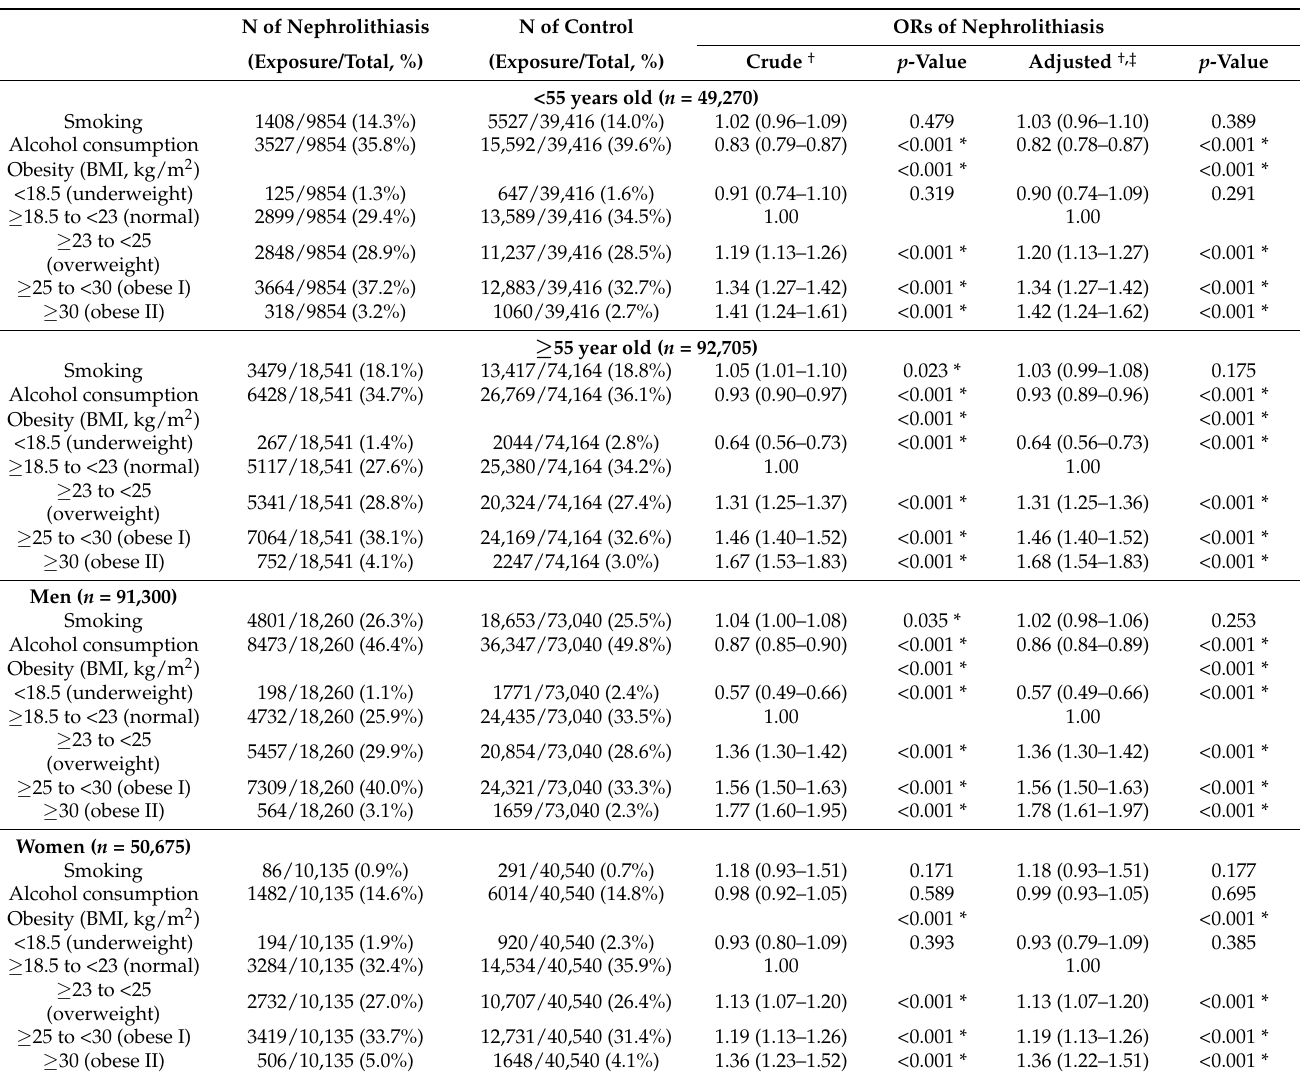
Table 3. Crude and adjusted odd ratios (95% confidence interval) of smoking, alcohol consumption, and obesity for nephrolithiasis in each stratified group, according to age and sex. N of Nephrolithiasis N of Control ORs of